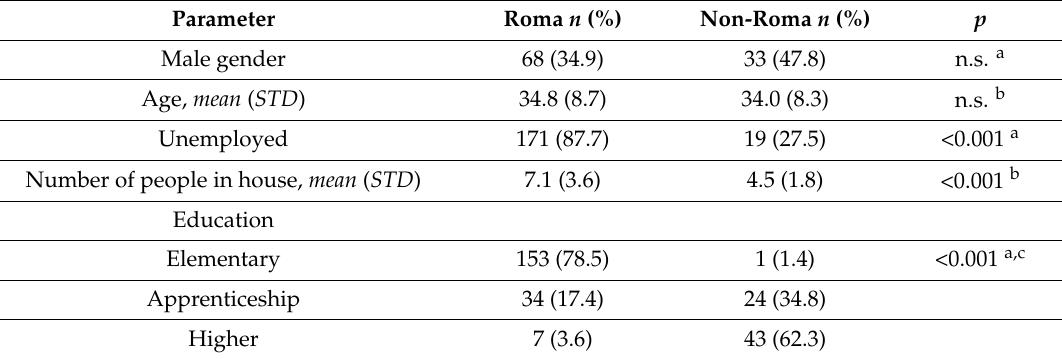
Table 1. Basic characteristics of the Roma ( n = 195) and non-Roma ( n = 69) samples and p-values for differences between the Roma and non-Roma population in eastern